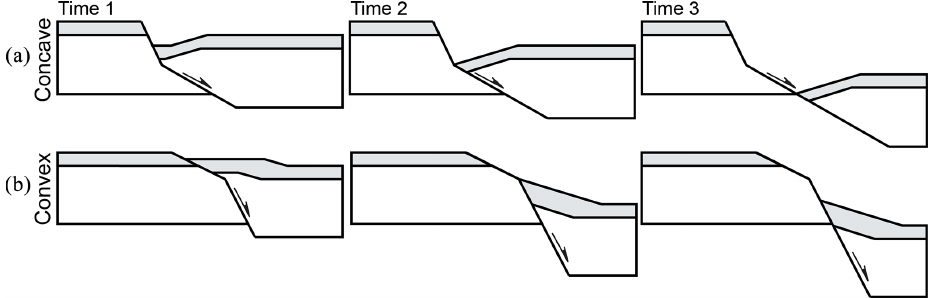
Figure 4. Block diagrams illustrating the evolution of the hangingwall deformation associated with (a) concave and (b) convex fault bends with increasing displacement at times 1 to 3. As soon as the hangingwall fault cutoff reaches the bend and begins to move along the lower fault segment (from time 2 to time 3), the absolute amount of continuous deformation does not increase anymore, resulting in a progressive decrease in its proportion to the total